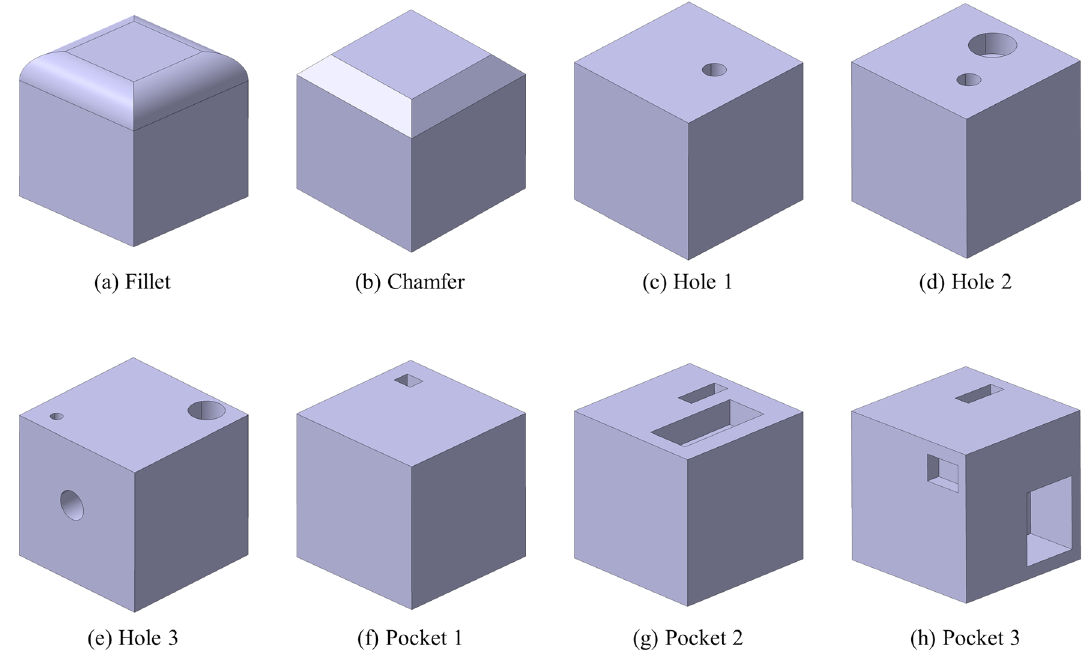
Figure 1. Types of machining features used in our study.